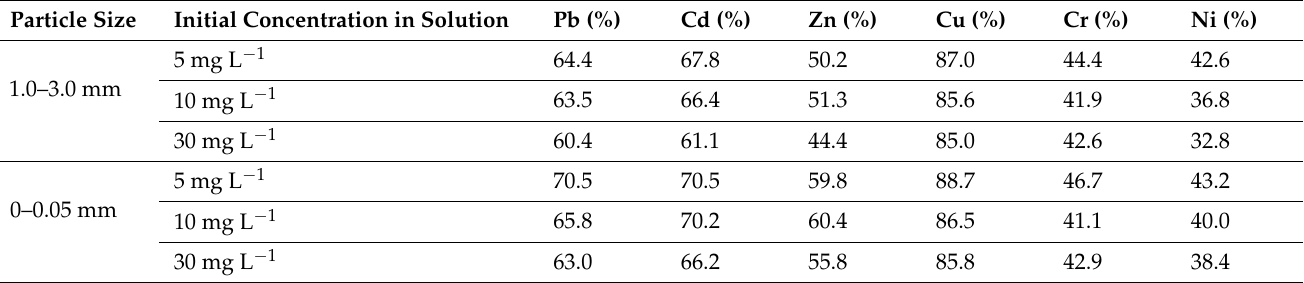
Table 6. Desorption rate (%) of Pb, Cd, Zn, Cu, Cr, and Ni from zeolite with a 0–0.05 mm